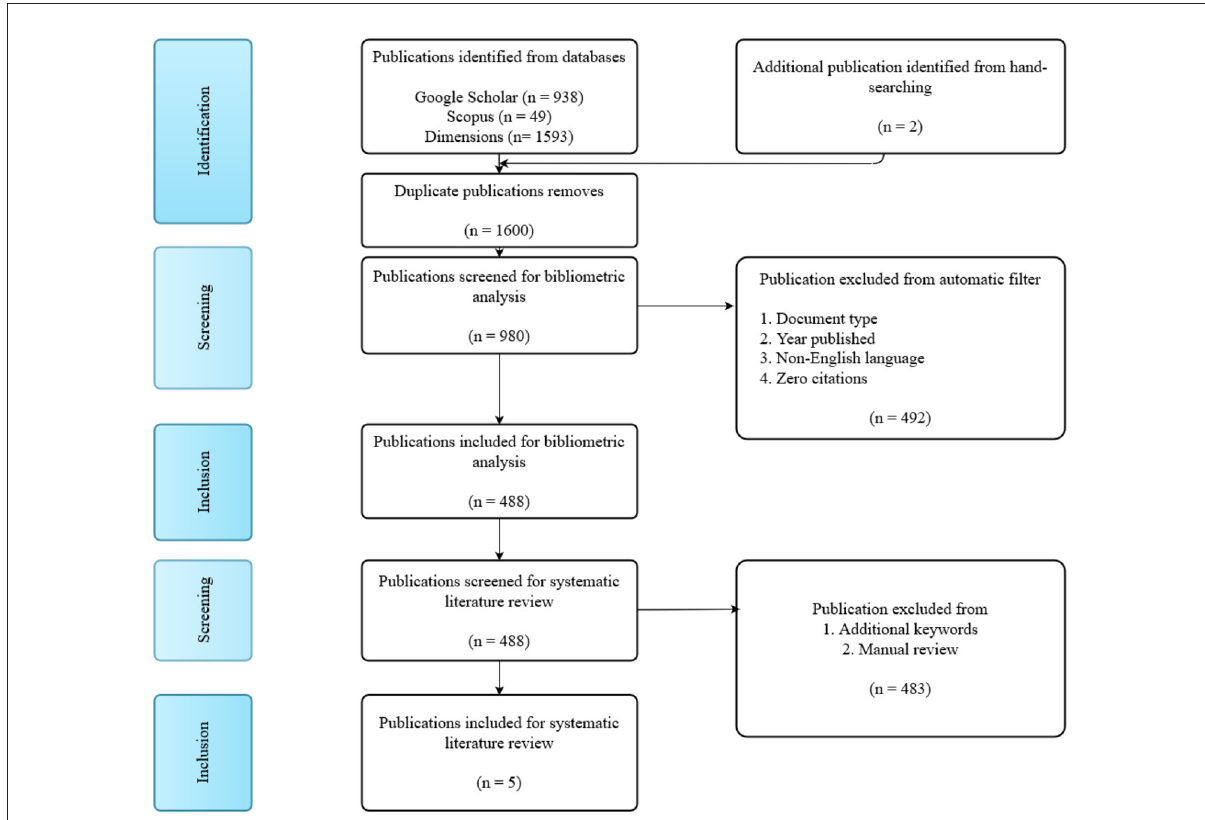
FIGURE1 Flow diagram of identification and inclusion of spatio-temporal general product-sum research works.